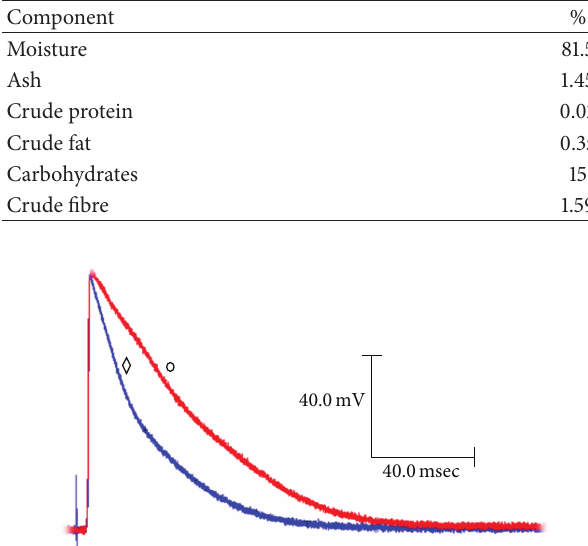
Table 1: Analysis of the composition of the lyophilized apple peel (RD).